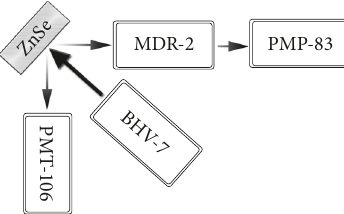
Figure 1: Geometry of XRL and TSL spectra registration.